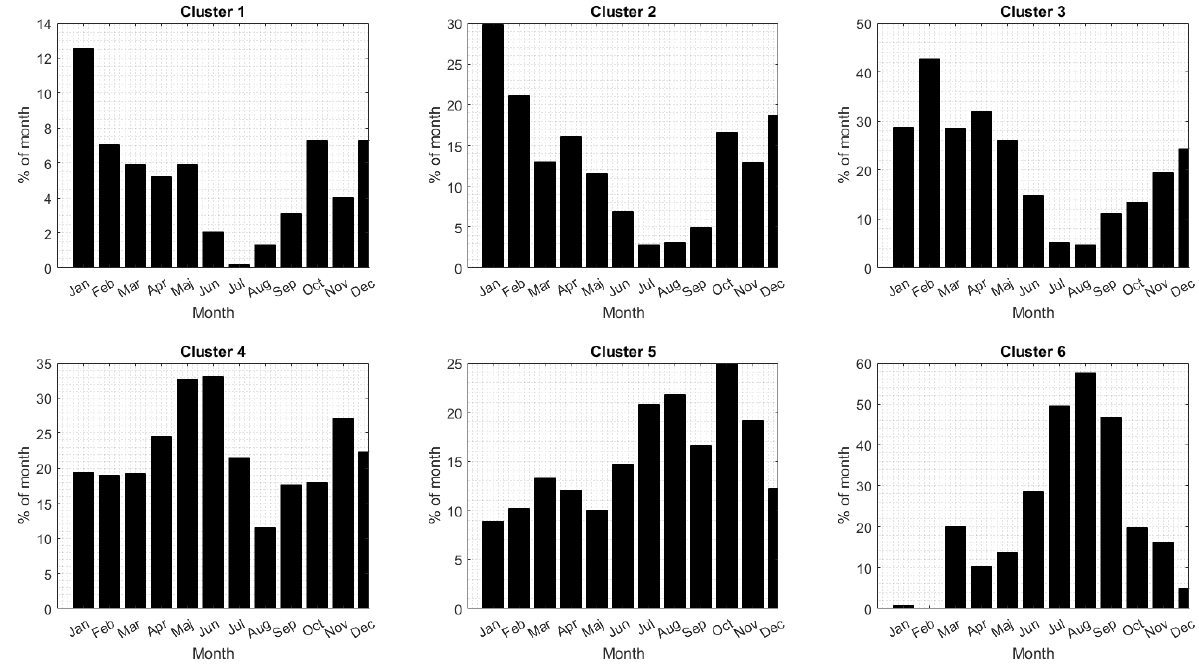
Figure 13. The relative frequency of occurrences of observations belonging to cluster 1–6.